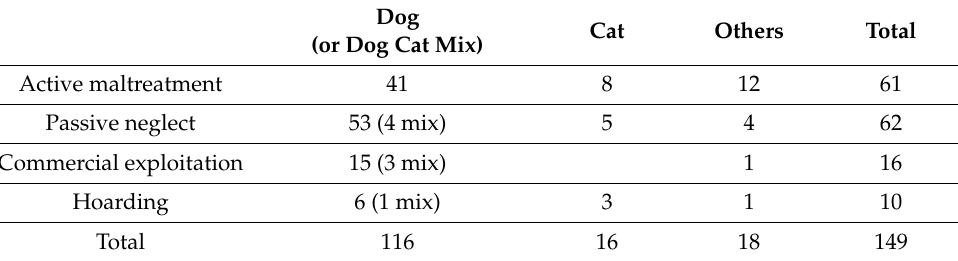
Table 1. Animal species by case